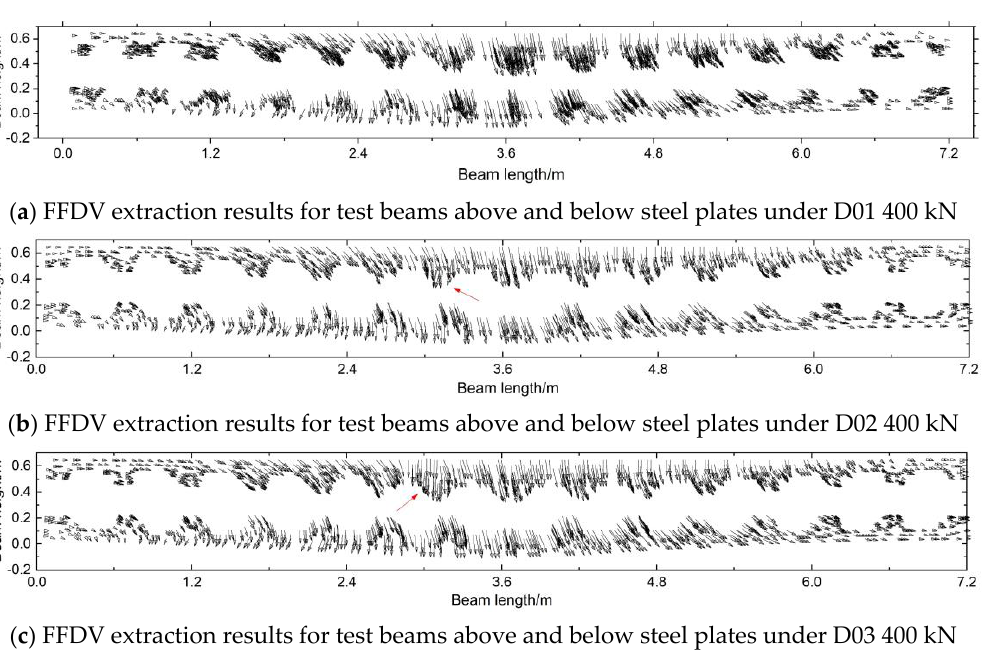
Figure 29. FFDV extraction results for test beams above and below steel plates.